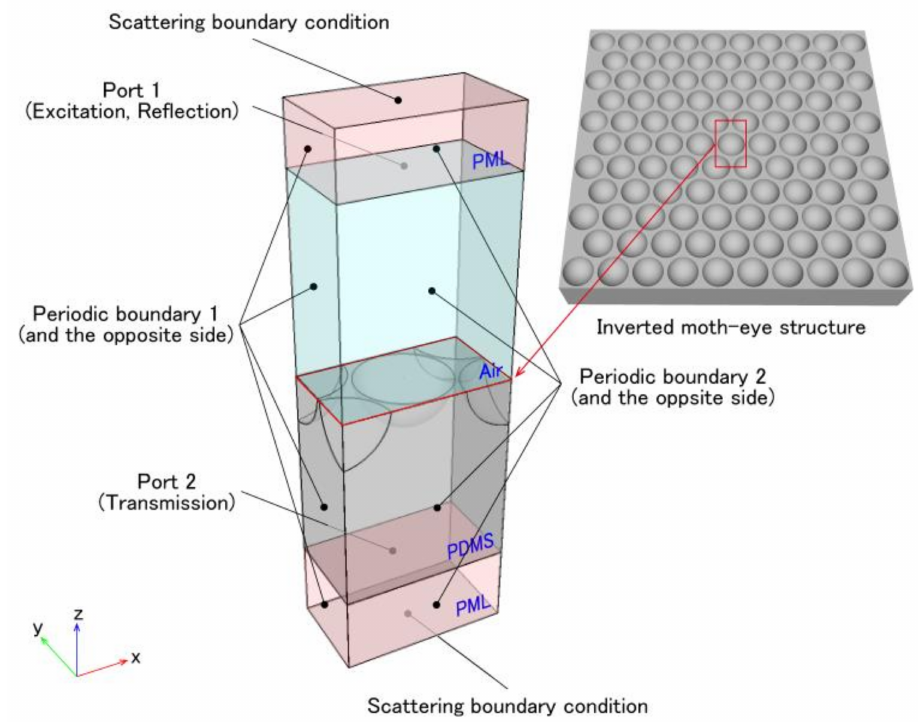
Figure 1. Unit cell employed as a finite element model of the inverted moth-eye structure in the COMSOL Multiphysics RF